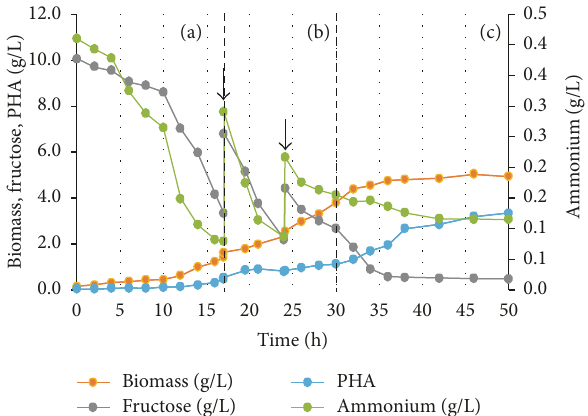
Figure 2: Profiles of fructose (grey circles), ammonium (green circles), biomass (orange circles), and poly-R-hydroxyalkanoate (PHA) (blue circles) production during the cultivation of Cupri- avidus necator on fructose and avocado oil (20% v/v) in three- stage fermentation. Stage 1: batch cultivation (a), Stage 2: fed-batch stage (additions indicated by black arrows) (b), and Stage 3: PHA accumulation (c). Oil addition occurs at